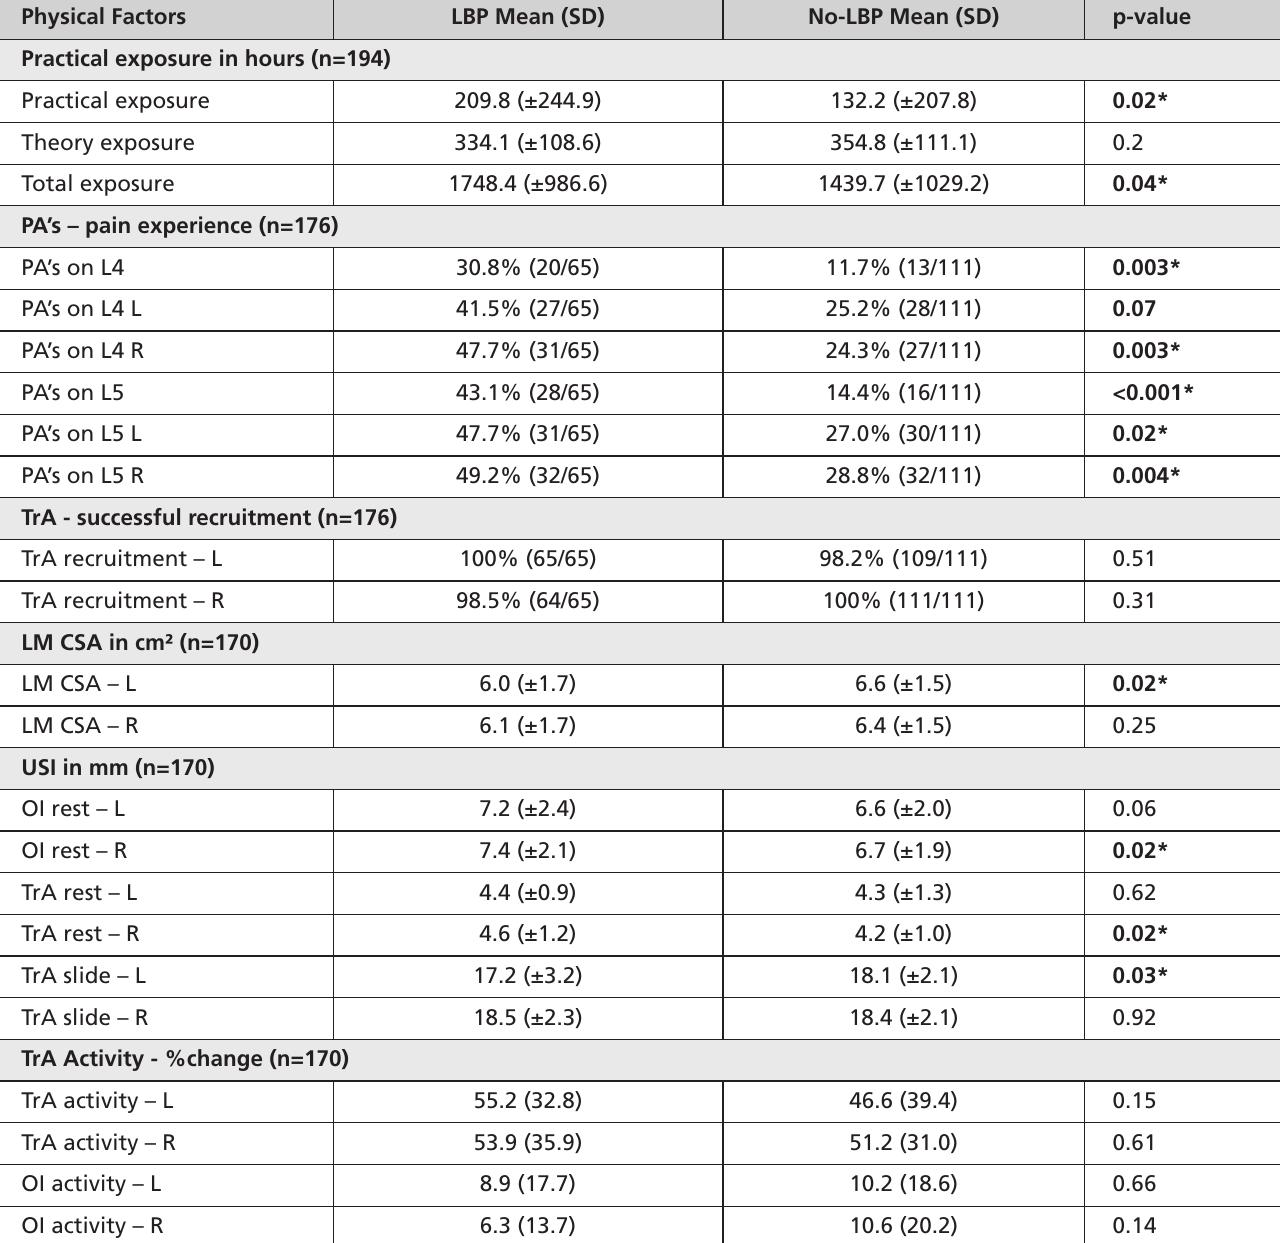
Table 3: Association of Low Back Pain and Physical Factors Physical